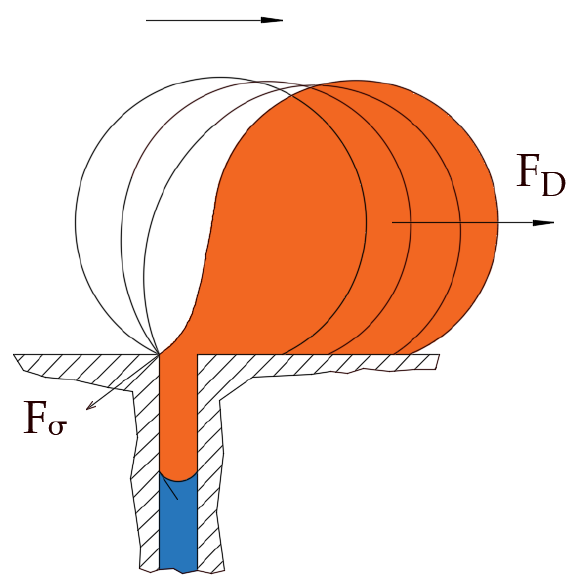
Figure 1. Schematic of the hydrodynamic and interfacial tension forces acting on a pinned oil droplet undergoing permeation in crossflow filtration. F D is the drag force due to the crossflow field, and F σ is the interfacial tension force.